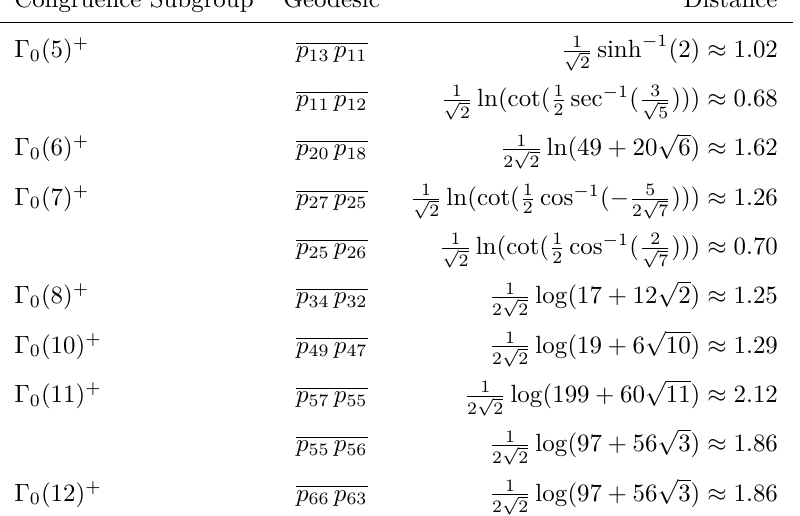
Table 2 . Finite distance geodesics in X 0 ( N ) + for 5 ≤ N ≤ 12